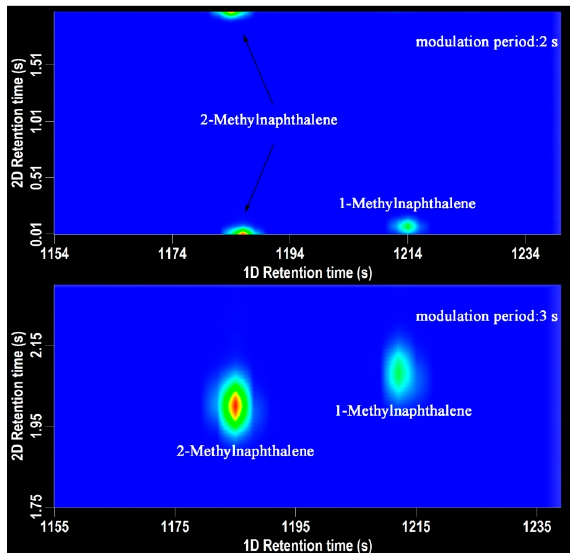
Figure 1. The 2D chromatography of 2-methylnaphthalene and 1-methylnaphthalene. (top-modulation period 2 s, bottom-modulation period 3 s).